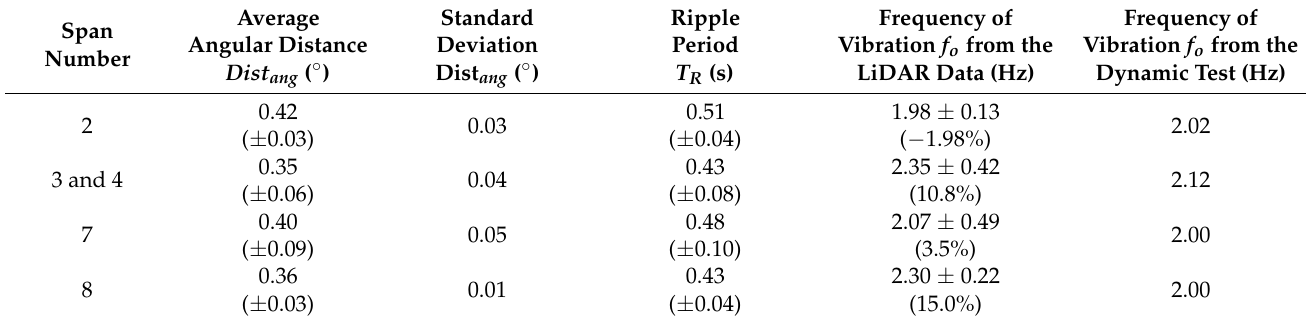
Table 2. Bridge Frequency of Vibration.